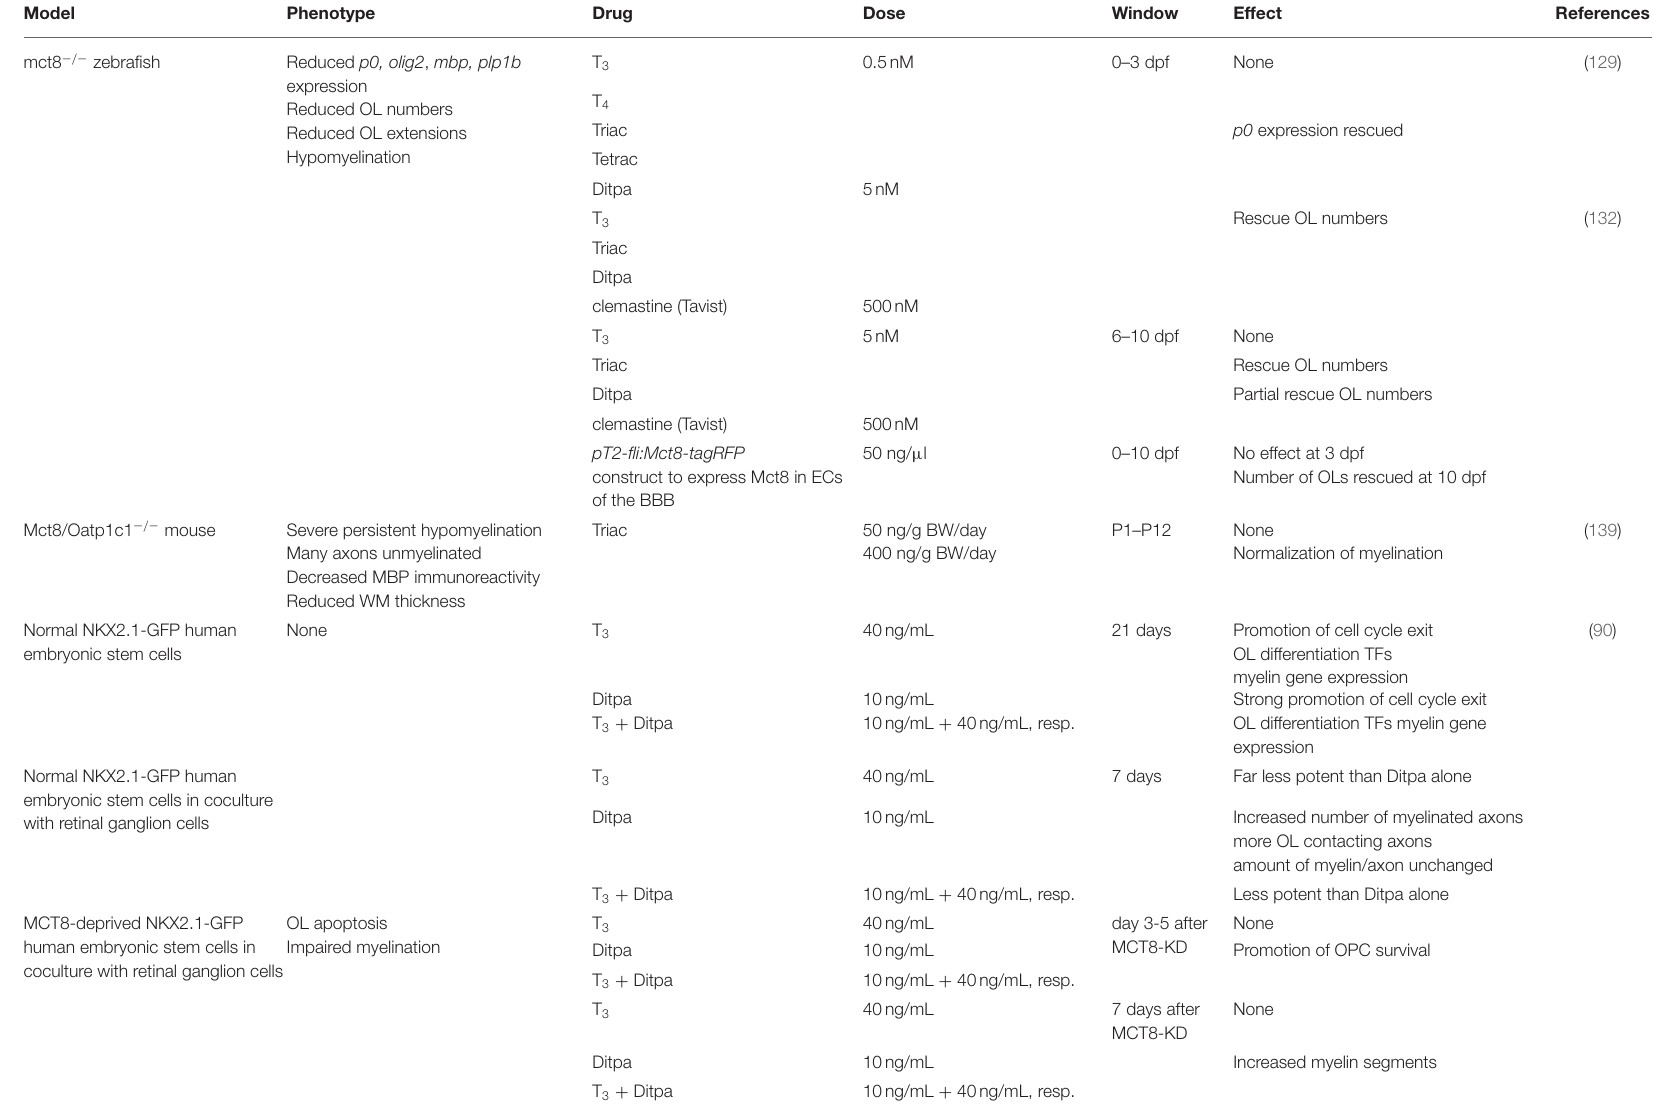
TABLE 3 | Current studies investigating effects of THs, TH analogs and other therapies on the myelination phenotype in models of MCT8 deficiency and human AHDS